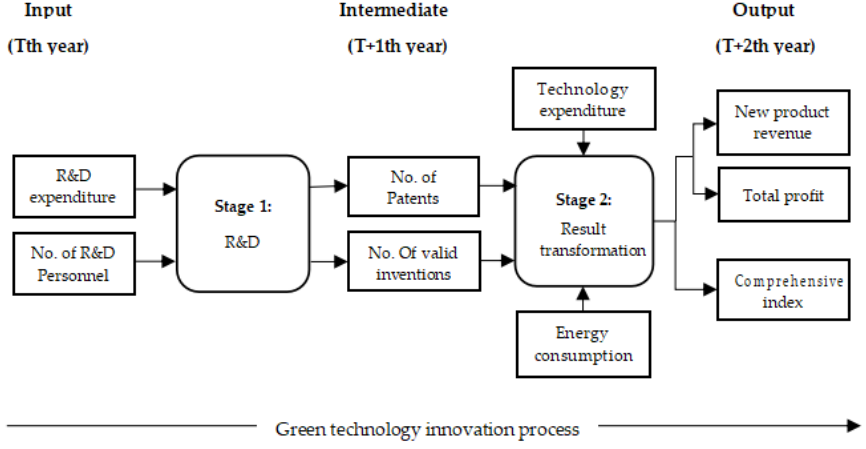
Figure 1. Logic Model of the Production Process of High-tech Manufacturing Industry.